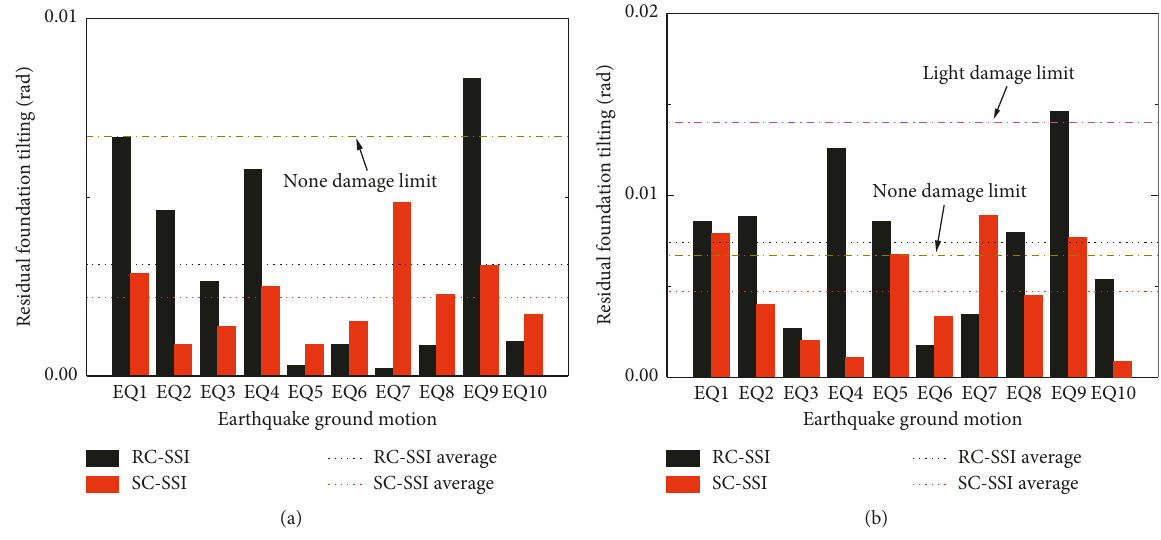
Figure 12: Residual foundation rotations of the RC-SSI and SC-SSI frames. (a) DBE. (b)